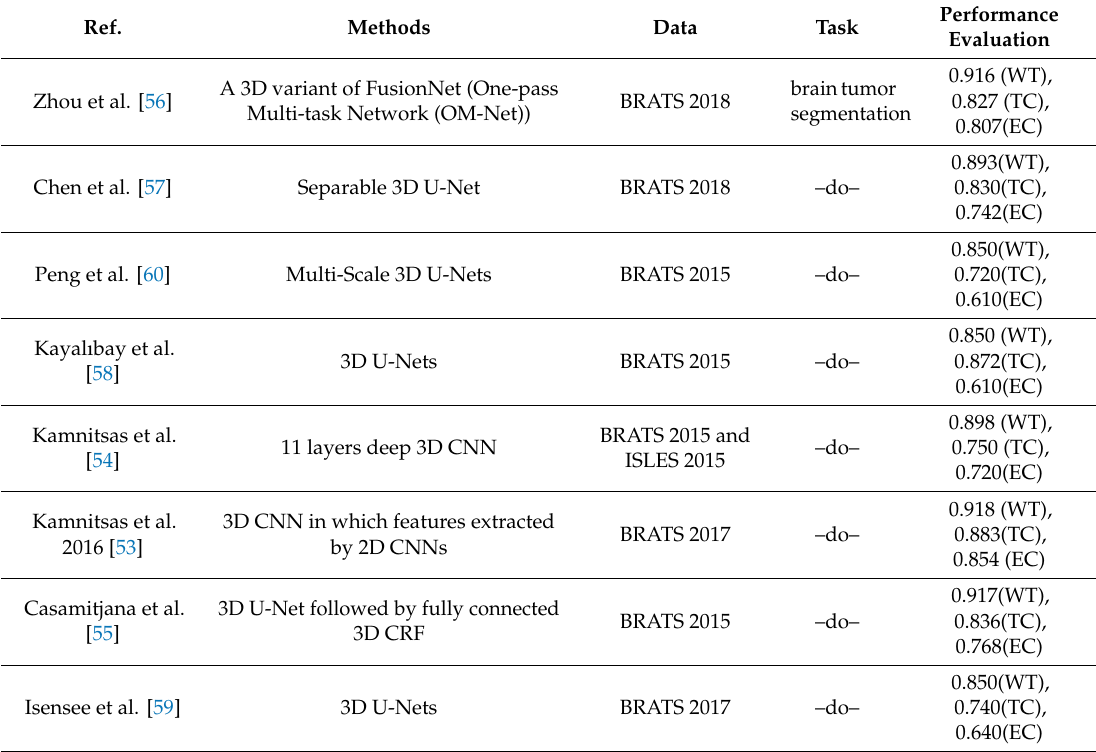
Table 1. 3D CNN for brain tumor / lesion segmentation on brain tumor segmentation (BRAST) challenges.